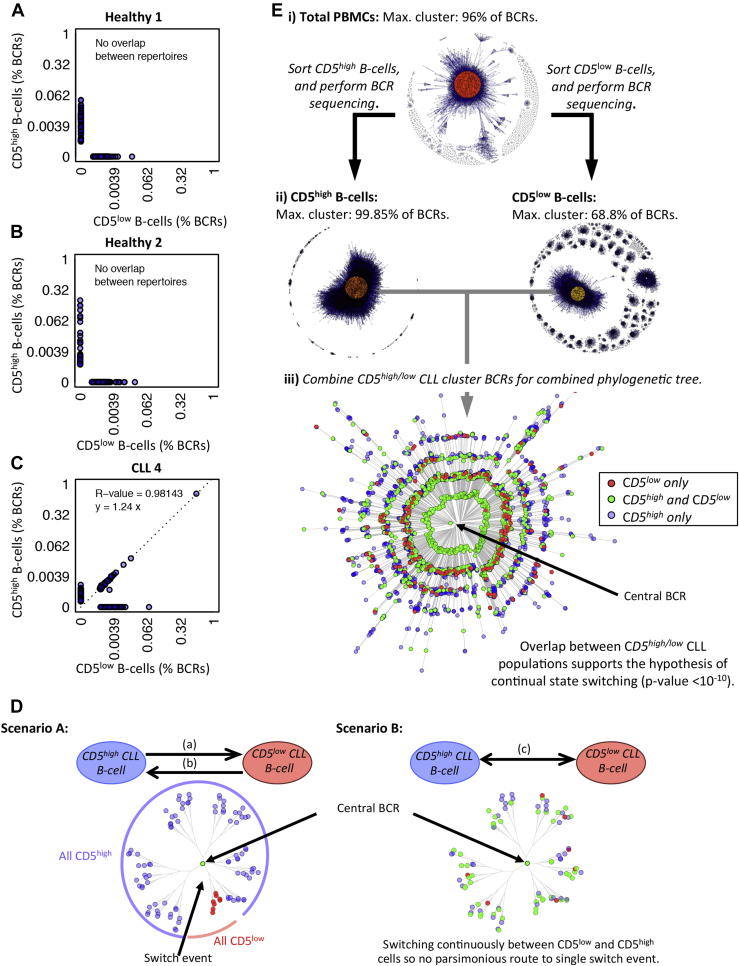
Comparison of CD5high and CD5low B-cell populations. Shown are plots of the frequencies of individual BCRs between CD5low and CD5high B-cell populations for healthy patient 1 (A), healthy patient 2 (B), and CLL patient 4 (C) as determined by sequencing the BCR repertoires using MiSeq. For CLL patient 4, in whom there is an overlap between CD5low and CD5high samples, the least-squares regression line equation and R2 value was determined for all BCRs, as indicated. (D) Theoretical model of CD5-state switching: unidirectional switch from CD5high to CD5low (scenario A), unidirectional switch from CD5high to CD5low (scenario B), and bidirectional dynamics switching/alternating between states (scenario C). These processes can be either a rare event (occurring only from a single or low number of CLL B cells) or a common/continuous event (occurring from a large percentage of the CLL B-cell population). (E) Determining the dynamics of CD5 state-switching in CLL patient 4: BCR sequence networks for total PBMCs (Ei) and BCR sequence networks for separated CD5high B cells (Eii, left) and CD5low B cells (Eii, right). The dominant cluster sizes are indicated above each plot. (Eiii) Combined maximum parsimony phylogenetic tree of the CLL cluster generated using the combined CLL BCR sequences from the separated CD5high and CD5low B-cell populations from (Eii). The branch lengths are proportional to the number of base differences from the central BCR sequence (evolutionary distance) and the resulting tree tips are colored red if the BCR was observed in CD5low B cells only, blue if observed in CD5high B cells only, and green if observed in both CD5low and CD5high B cells. Bootstrapping was performed to evaluate the reproducibility of the trees, showing strong tree support (>90% certainty for all branches). The overlap between CD5low and CD5high CLL BCR populations was significantly greater than that expected by a rare CD5 state-switching event originating from the central BCR (p < 10−10).